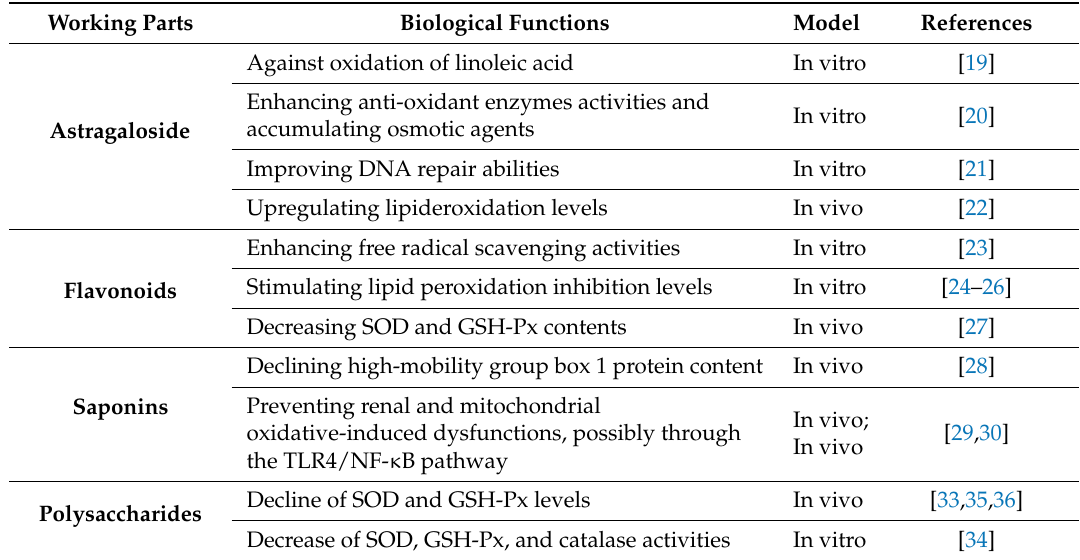
Table 1. The anti-oxidative functions of AR and its major